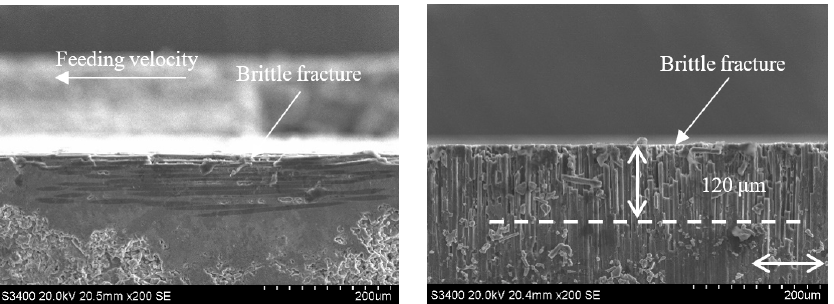
Figure 20. Grinding subsurface topography of the CG-C/SiC composite (v s = 1.26 m/s, a p = 0.1 mm, v w = 500 m/min).